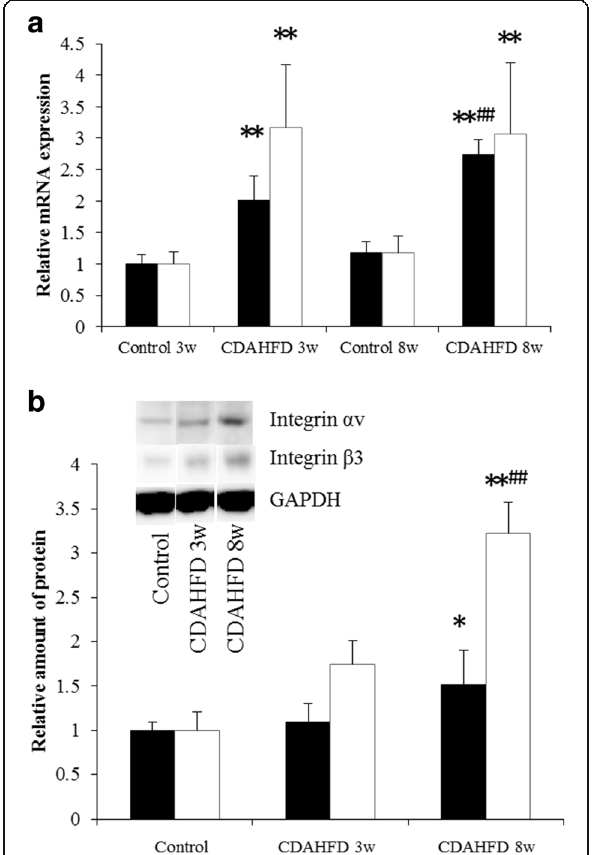
Fig. 6 Hepatic mRNA ( a ) and protein levels ( b ) of integrin α v and β 3 subunits in the livers of control and choline-deficient, L -amino acid-defined, high-fat diet (CDAHFD)-fed mice. Data are expressed as the mean±SD ( n =8 mice per group). Statistical differences were assessed using Steel-Dwass test. * p <0.05, ** p <0.01 compared with respective control mice. ## p < 0.01, compared with the CDAHFD 3 weeks group. White bar, integrin α v; black bar, integrin β